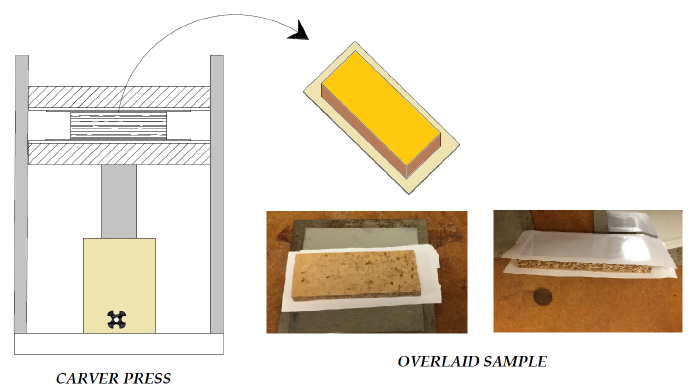
Figure 4. Overlaying Process.